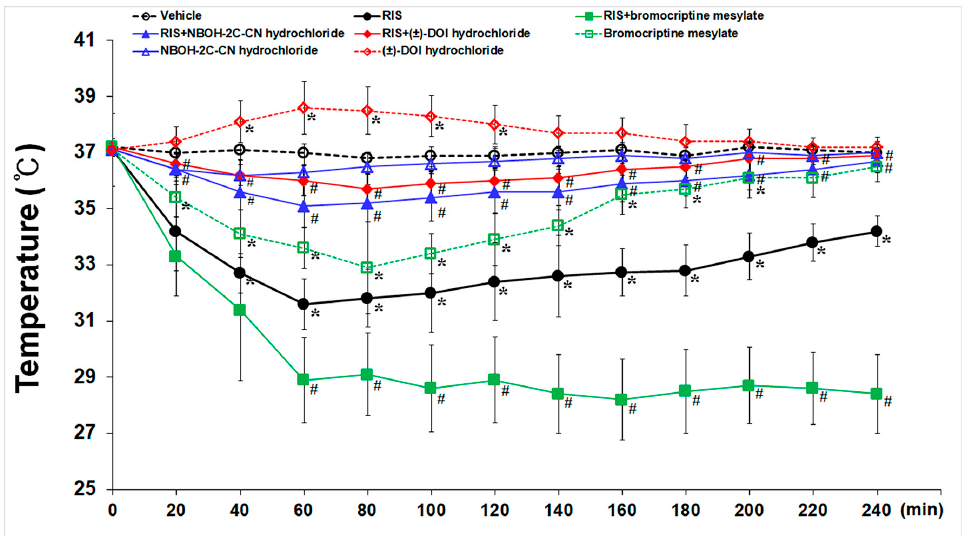
Figure 7. Effects of endogenous 5-HT 2A - and, D 2 - receptors on RIS-induced